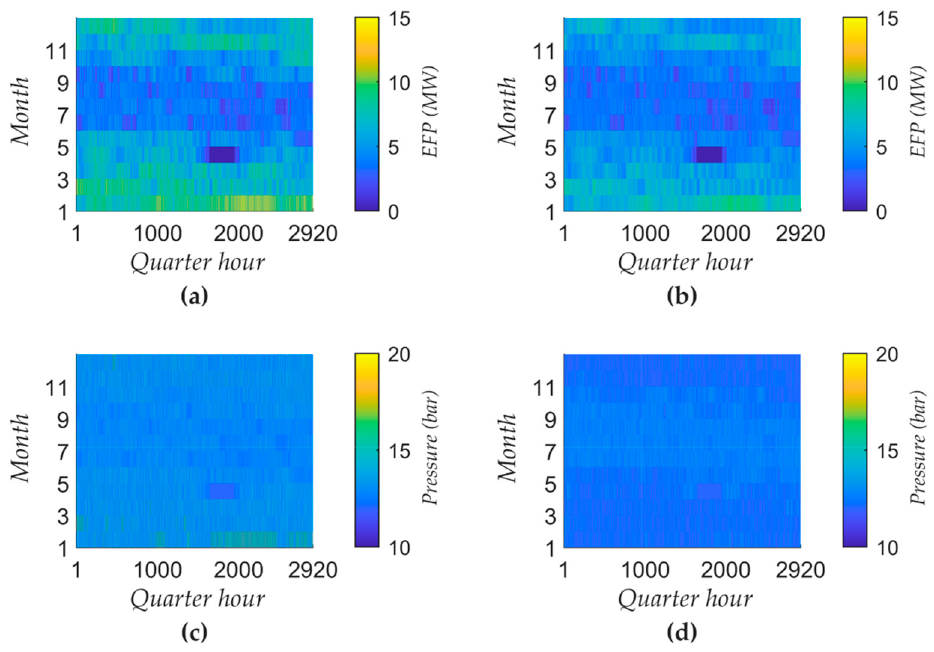
Figure 5. Theoretical and technical energy flexibility for negative secondary balancing power: ( a ) Theoretical energy-flexibility potential ( 𝐸𝐹𝑃 ); ( b ) Technical energy-flexibility potential ( 𝐸𝐹𝑃 ); ( c ) Theoretical pressure; ( d ) Technical pressure.